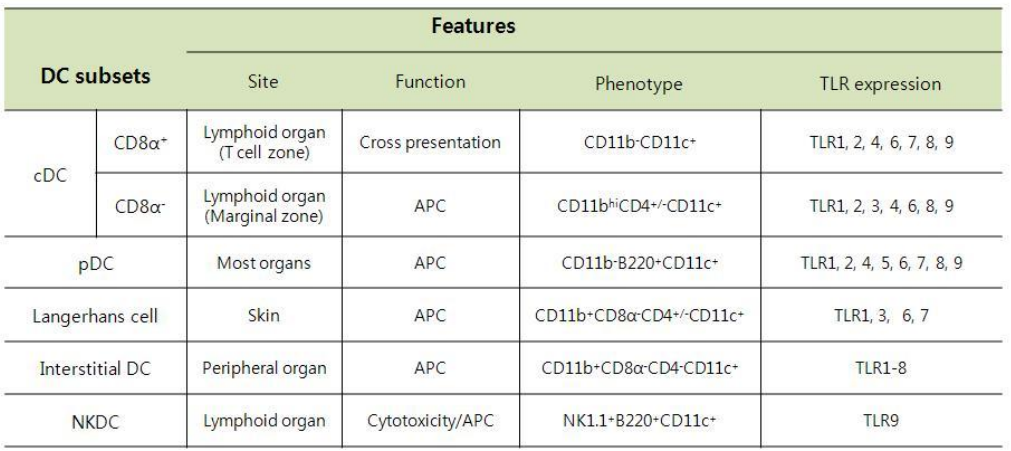
Table 1. Murine DC